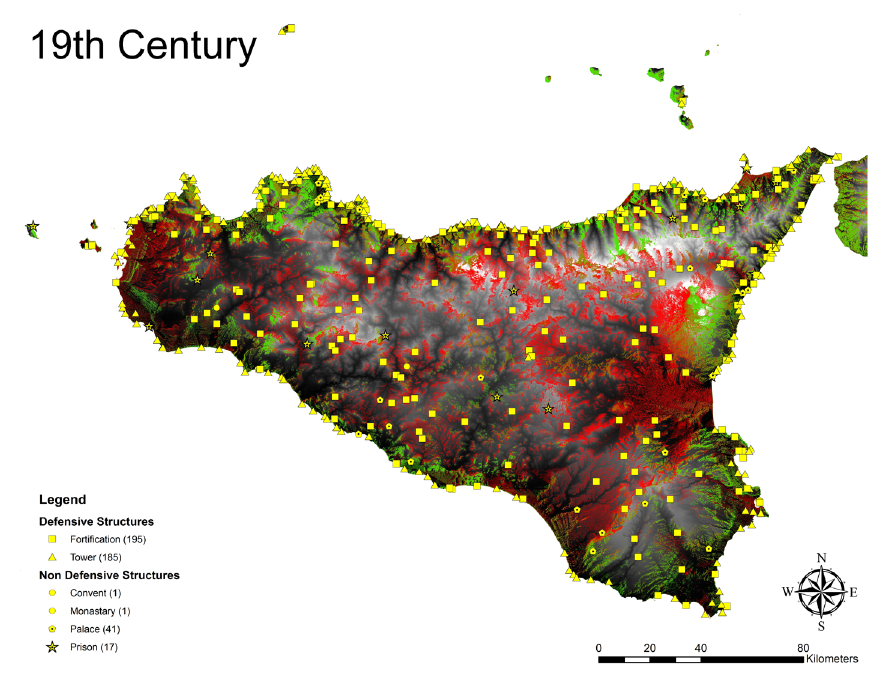
Figure 10. Figure showing the distribution of defensive structures and their viewsheds in the 19th century. Fortifications are represented by squares and the area they have surveillance over is in red whereas towers are represented by triangles and the area theyhave surveillance over is in green. Also included are church buildings represented by circles, palaces represented by hexagons, and prisons represented by a star. Image derived from an ASTER GDEM (a product of NASA and